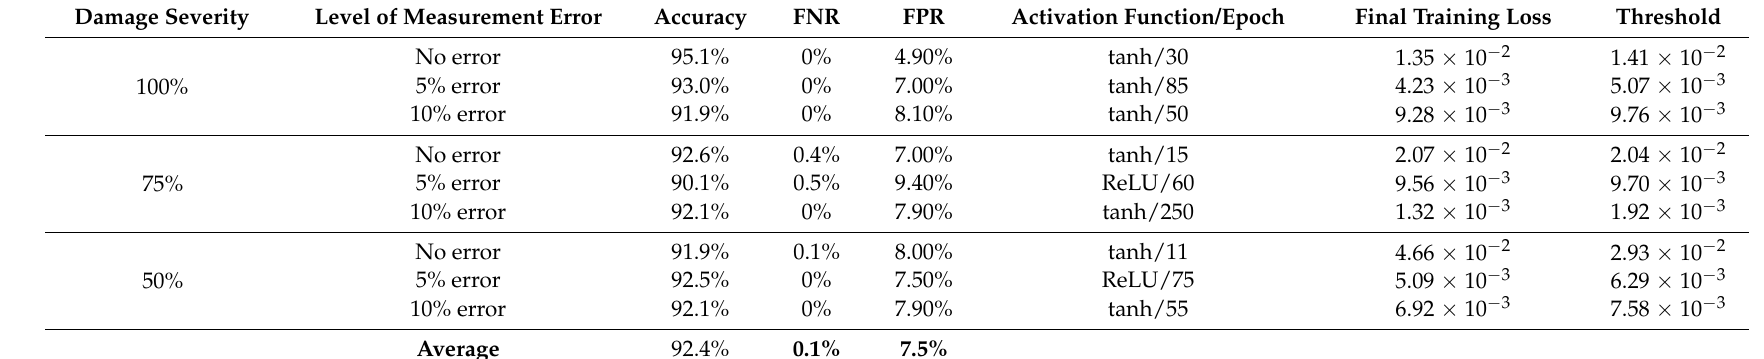
Table 4. Accuracies of the CAE models corresponding to the three levels of measurement errors for the single-vehicle traffic